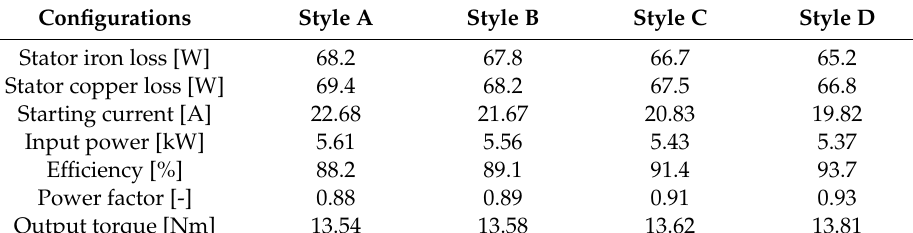
Table 6. Comparative performances for four kinds of SCSCRIM configuration design.